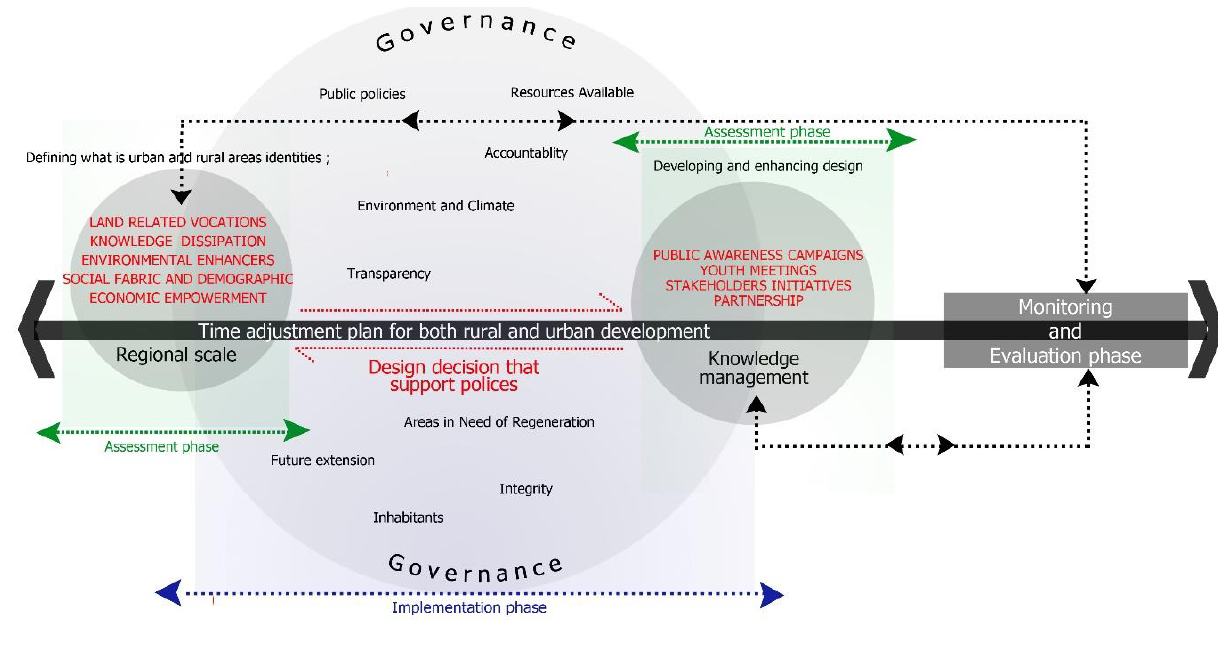
Figure 5: Proposed regeneration plan (Sources: